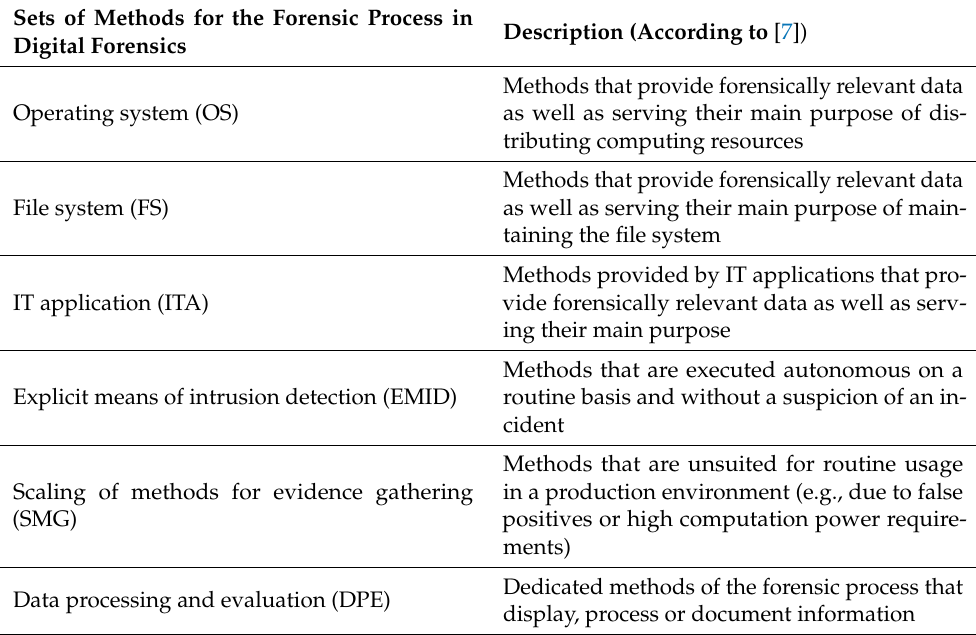
Table 4. Grouping of sets of methods for the forensic process in digital forensics defined in [7] (updated from